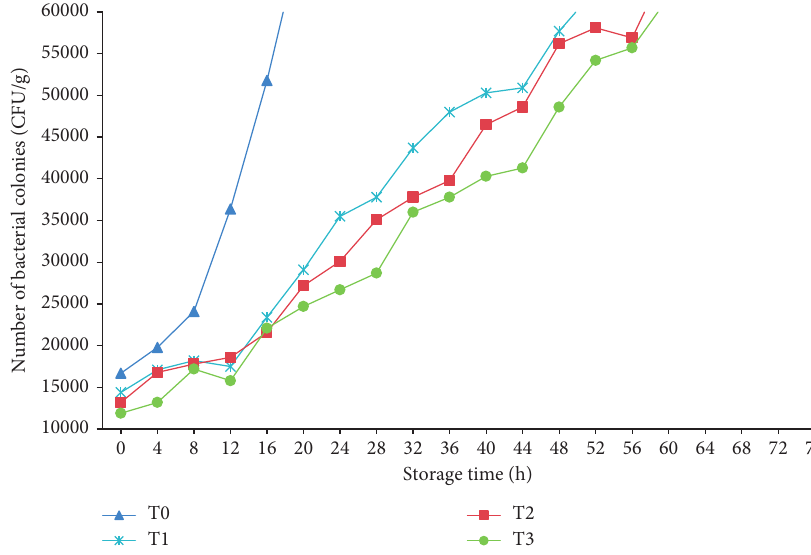
Figure 1: TPC test results on smoke powder-coated meatballs.